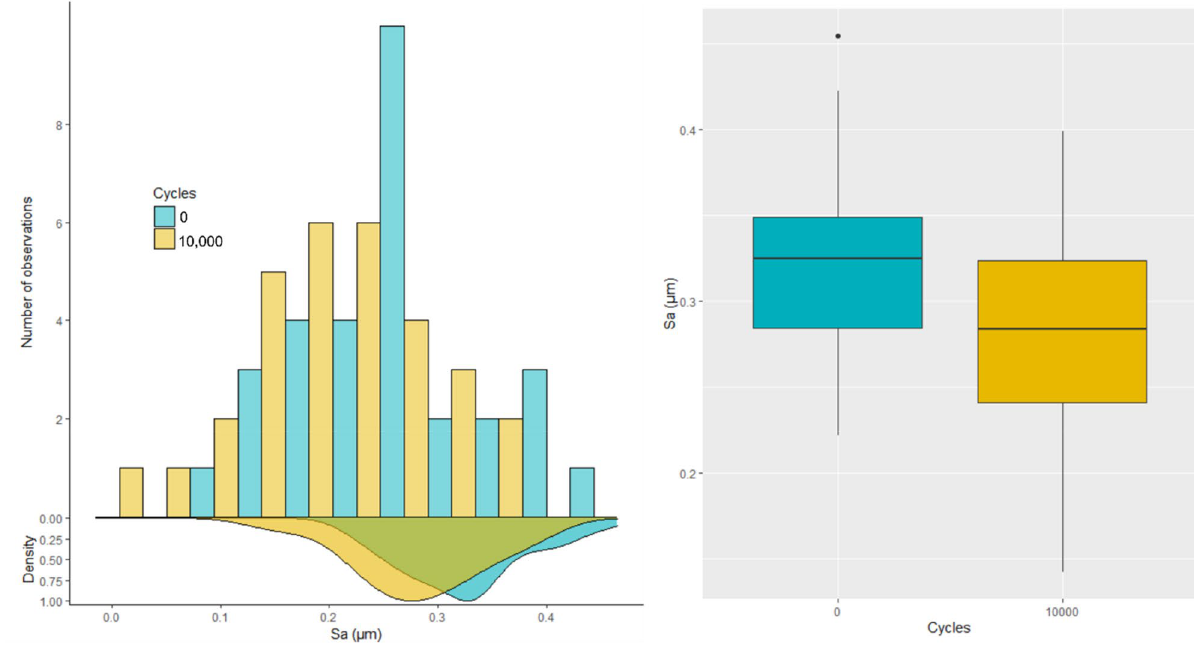
Figure 4. Histogram, density and boxplot of the arithmetic mean deviation Sa computed for all the measurements closest to the edge, after using a high-pass filter with a cut-off length of 25 µm.